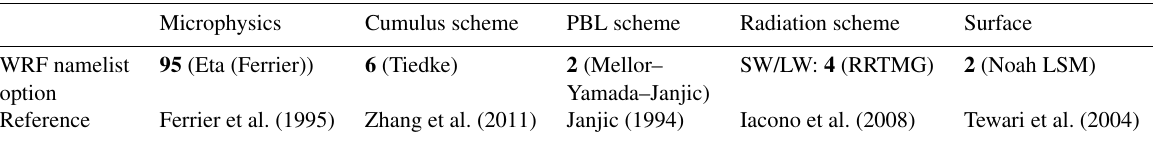
Table 2. Physical parameterisation schemes used in the regional model simulations (same parameterisations used for 50 and 12.5km do- mains). PBL indicates the planetary boundary layer. Bold numbers indicated the chosen namelist